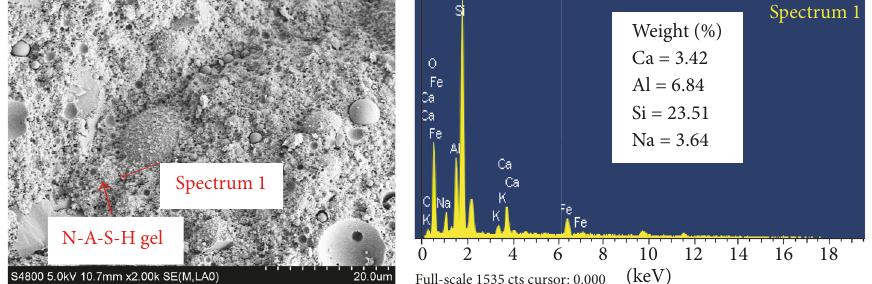
Figure 18: SEM and EDS results of FAGC in the heating